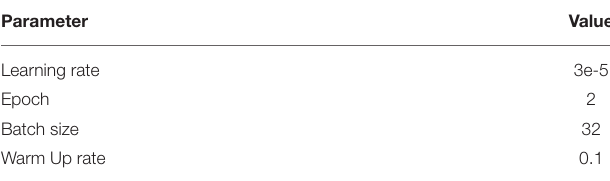
TABLE 3 | Model training parameter